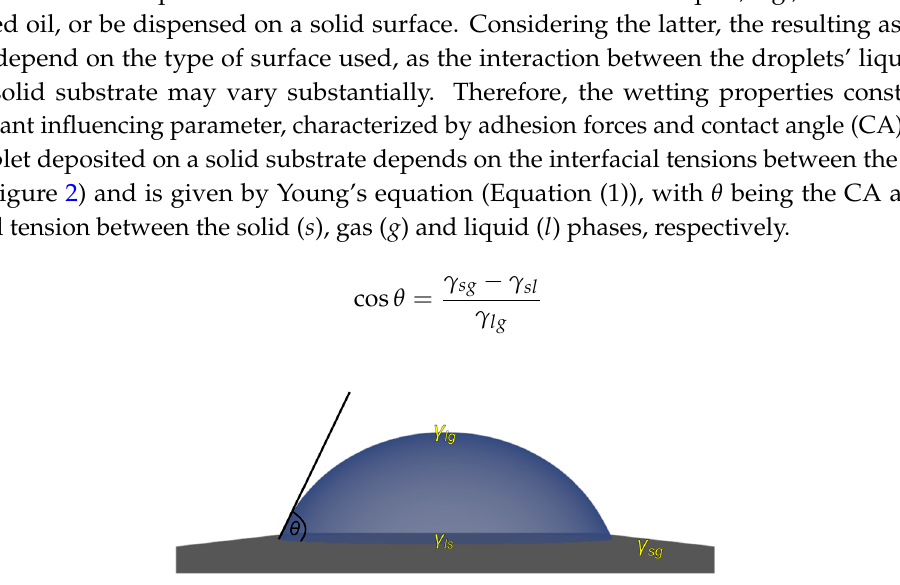
Figure 2. Scheme describing the contact angle (CA) θ of the liquid droplet on a solid substrate and its relation to the different interfacial tensions between the solid ( s ), liquid ( l ) and gas ( g ) phase, as related to each other by Equation (1).